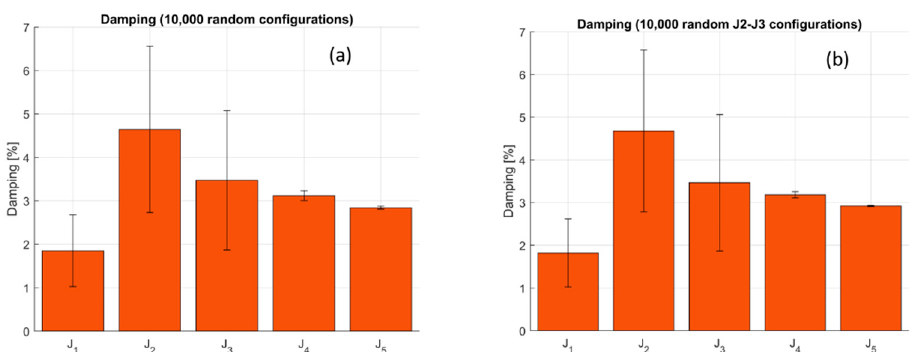
Figure 13. Mean values and standard deviations of modal damping in the workspace, ( a ) random variations in J2, J3, J4, J5, ( b ) random variations in J2 and J3.